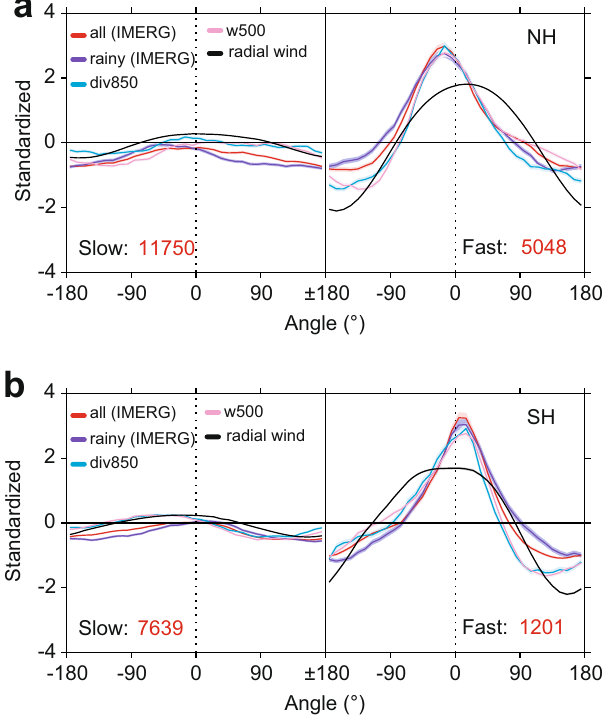
Fig. 3 | Azimuthal distributions of two variables with different vertical wind shear (VWS) directions. Left and right panels in each sub- fi gure represent a tropical cyclone (TC) rain rate and b the probability of VWS in slow- and fast- moving TCs, respectively. The x axis is the difference between the TC motion directionandthesheardirection, “ 0 ” representsthatthedirectionsofVWSandTC motion are the same, “ ±180 ” represents the directions of VWS and TC motion are opposite, and clockwise is positive. Colors are for Northern Hemisphere (NH, red) and Southern Hemisphere (SH, blue), and shaded areas in a represent the standard